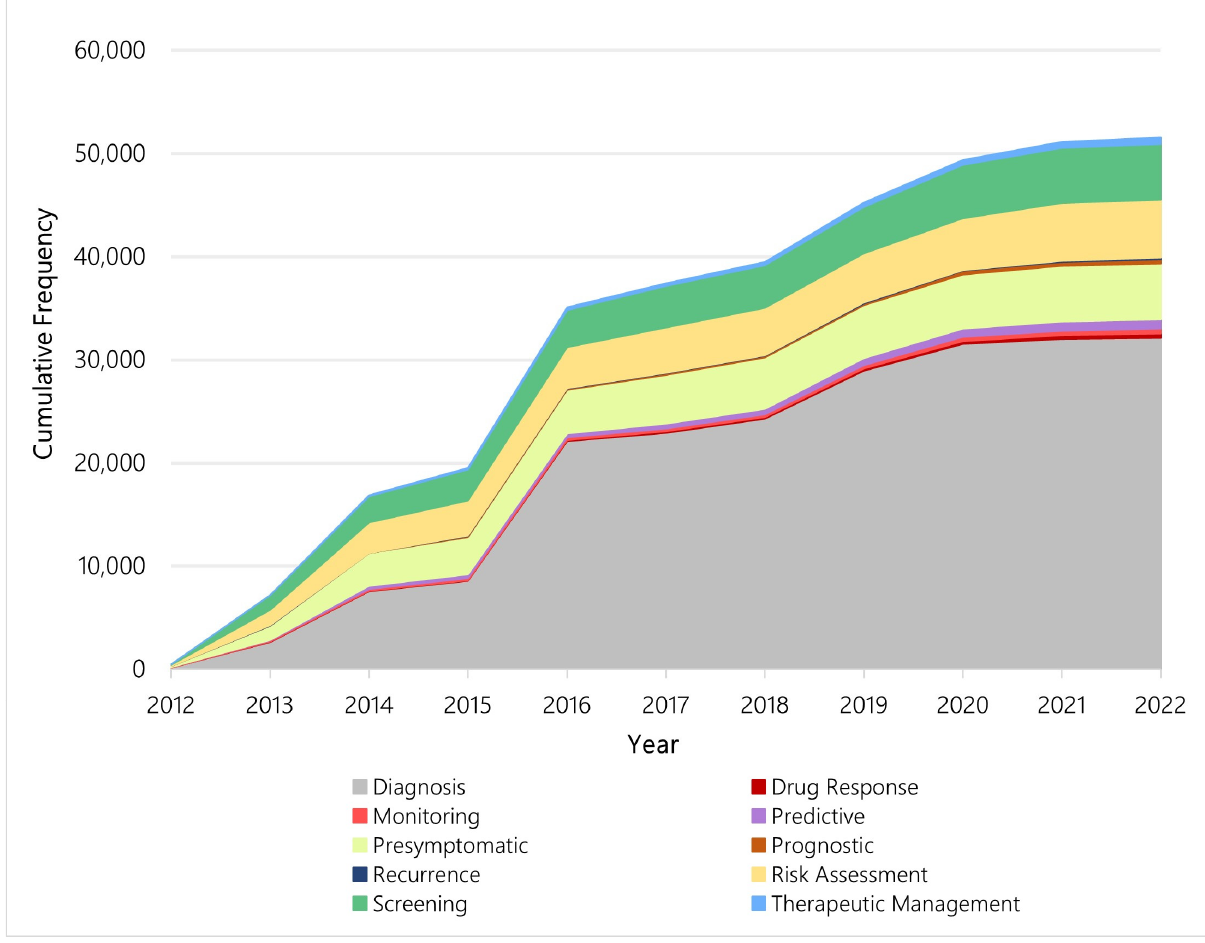
Figure 4. Percentage of new genetic tests in the U.S. from 2012 to 2022 by CLIA-certified laboratory.